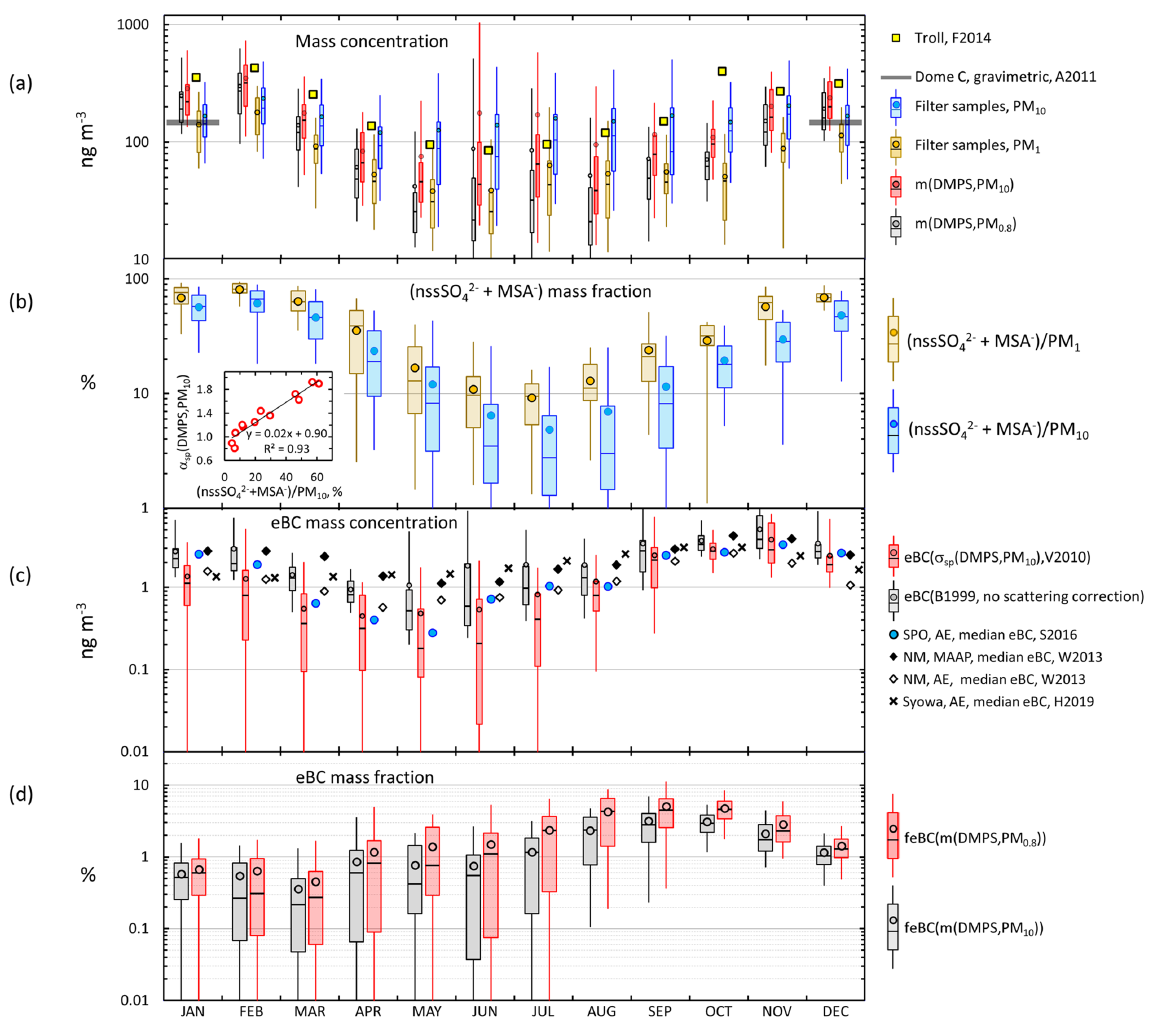
Figure 11. Seasonal cycles of (a) aerosol mass concentration calculated from the particle number size distributions m (DMPS,PM 10 ) and m (DMPS,PM 0 . 8 ), the sum of ions analyzed from PM 1 and PM 10 filters, (b) mass fraction of the sum of nssSO 2 − and MSA in PM 1 and 4 PM 10 filters, (c) equivalent black carbon (eBC) concentration calculated from the non-scattering-corrected absorption coefficients and from σ ap corrected with the σ sp upper estimate ( σ sp (DMPS,PM 10 )), and (d) mass fraction eBC calculated as the ratio of eBC corrected with the σ sp upper estimate to m (DMPS,PM 0 . 8 ) and m (DMPS,PM 10 ). Comparison values: (a) monthly average mass concentration calculated from particle volume concentrations at Troll (F2014: Fiebig et al., 2014), average gravimetric PM 10 mass concentration at Dome C (A2011: Annibaldi et al., 2011), and (c) monthly median eBC concentrations measured at Neumayer (NM) with a MAAP and an Aethalometer (AE) (W2013: Weller et al., 2013), at the SPO with an Aethalometer (S2016: Sheridan et al., 2016), and at Syowa with an Aethalometer (H2019: Hara et al., 2019). The small insert in panel (b) shows the scatter plot and linear regression of monthly average α sp (DMPS,PM 10 ) vs. monthly average mass fraction of the sum of nssSO 2 − and MSA in PM 10 4